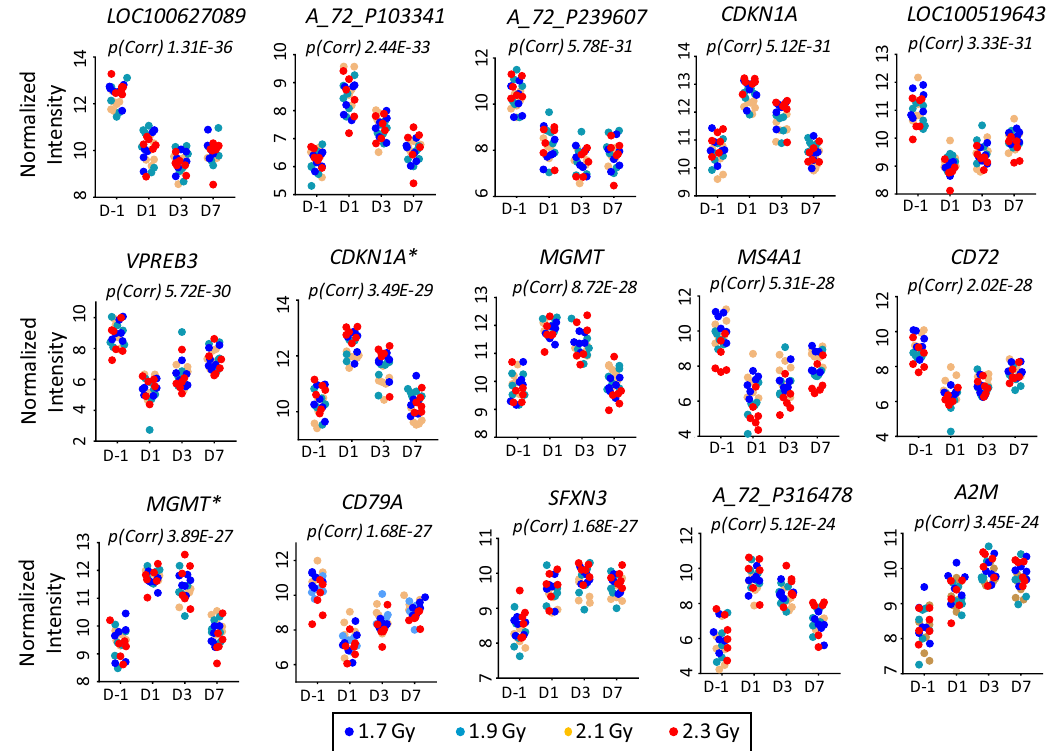
Figure 4. Scatter plots of the 15 most highly significantly regulated genes across all animals. The time-points of data collection are on the x-axis. D-1, D1, D3, D7 depict the day-1, day 1, day 3 and day 7, respectively. The normalized intensity values for each animal are plotted on the y-axis. *Signifies different probe for the same mRNA. Data points for 1.7 Gy, 1.9 Gy, 2.1 Gy and 2.3 Gy are depicted in dark blue, cyan, orange, and red,